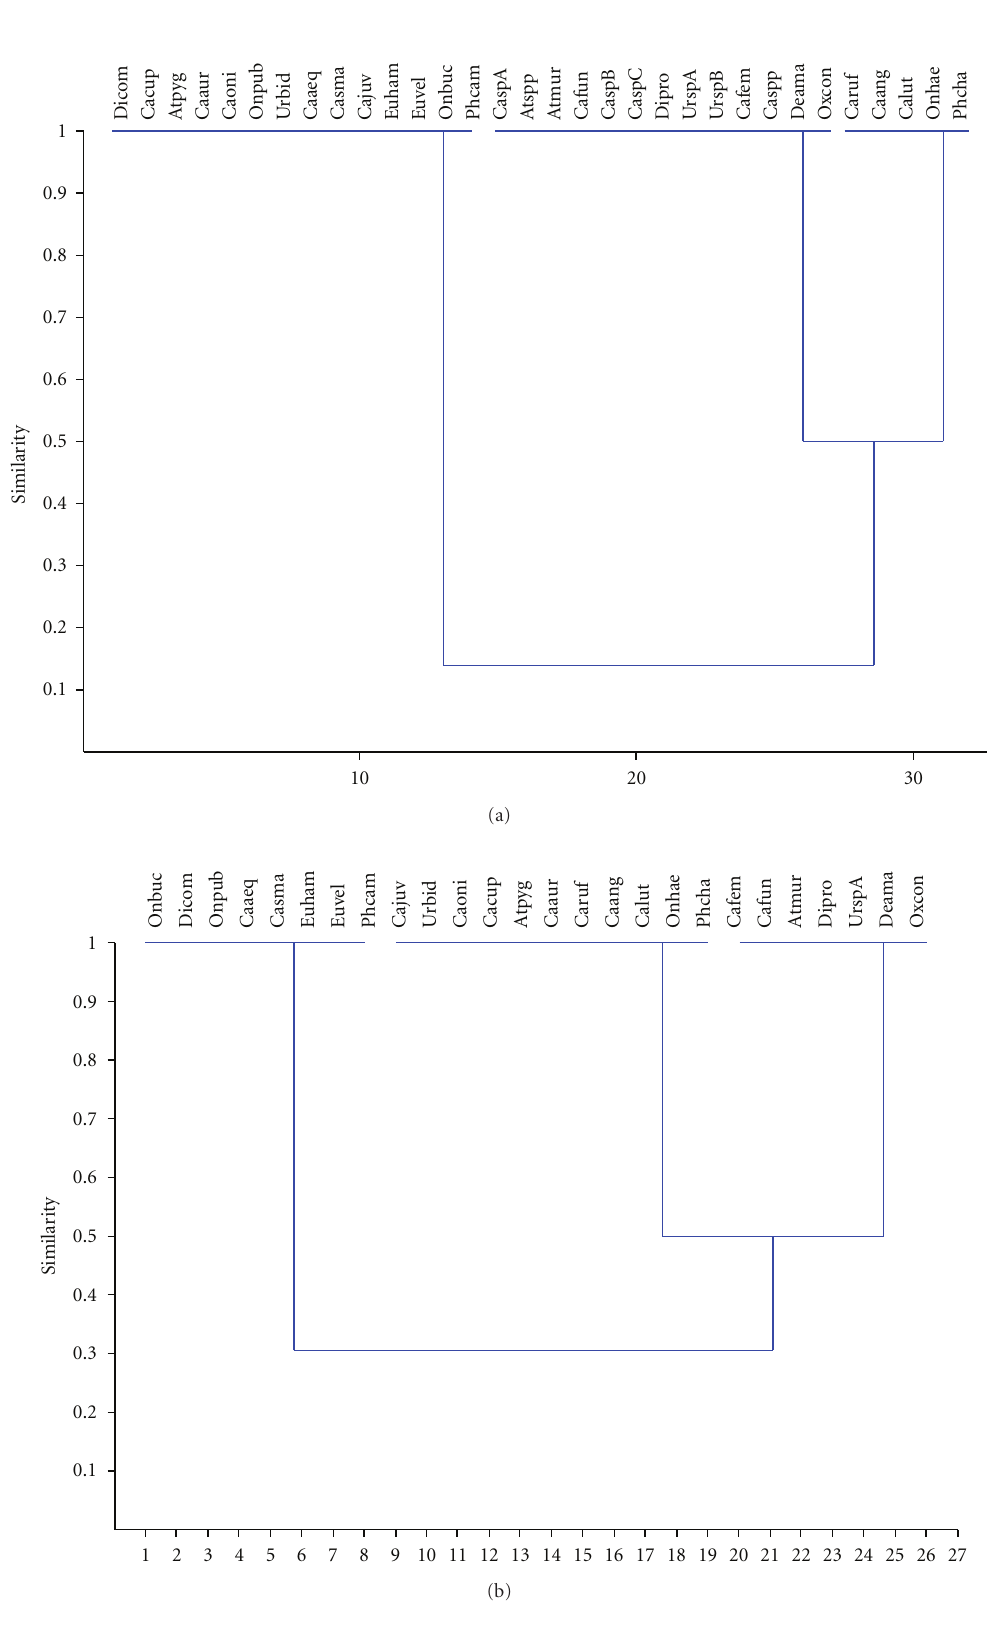
Figure 1: Dendrogram cluster analysis of similarity (Jaccard’s index) among species and the dung type they use in scenarios (a) and (b), CIEM-Meta,